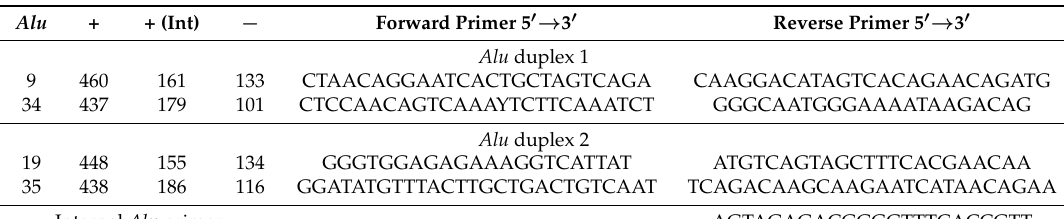
Table 1. Primers of both duplex PCRs with expected amplicon lengths in bp for Alu presence (+), internal (+ int) and Alu absence ( − )